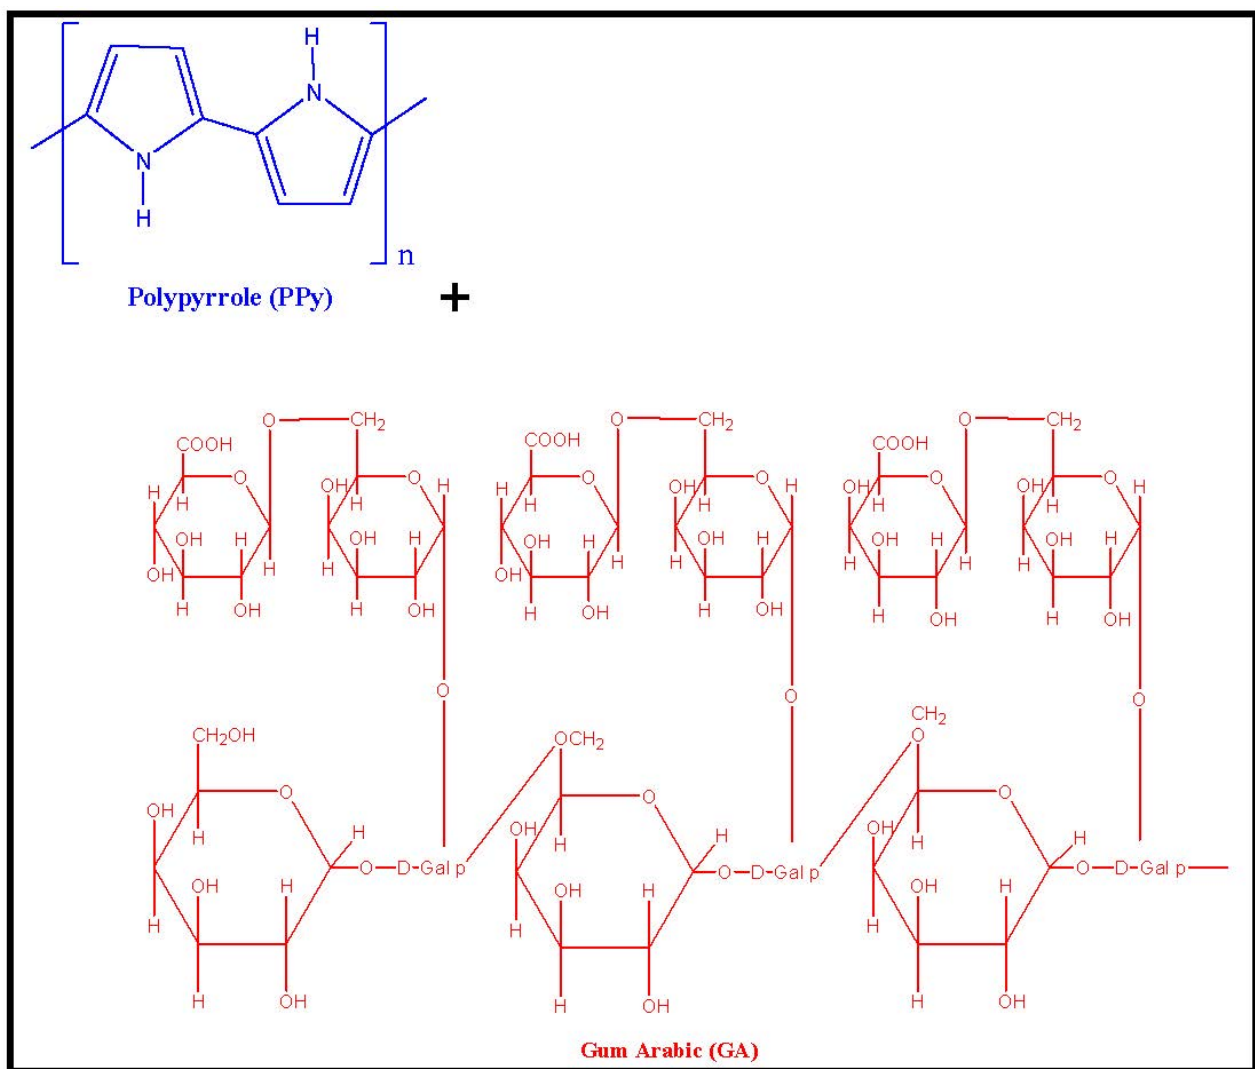
Scheme 1. Structural representation of reactants, i.e., polypyrrole and gum